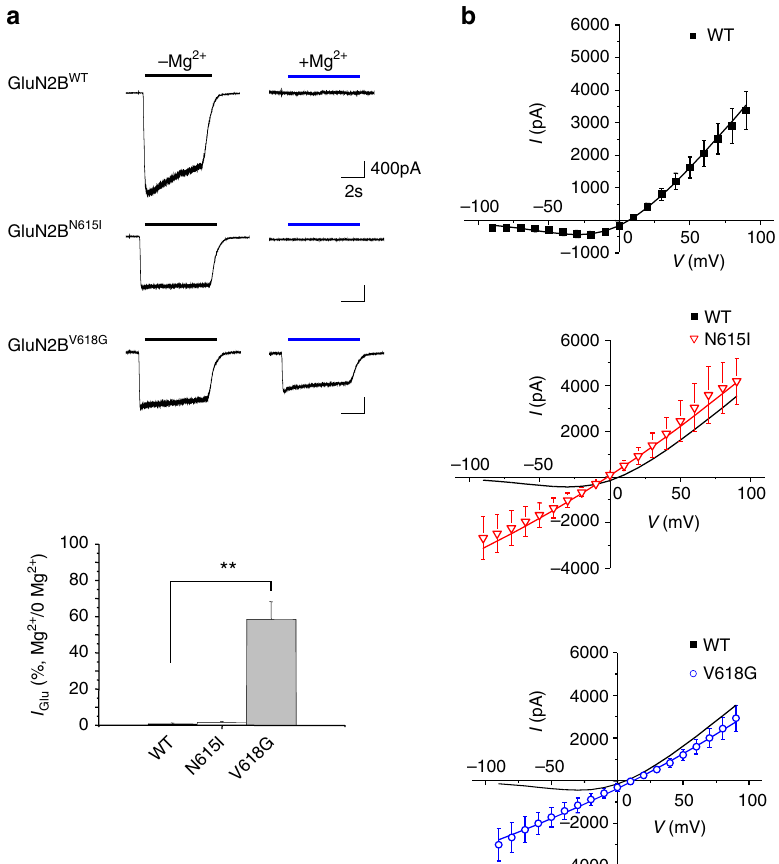
Fig. 4 Mg 2+ permeability and block of NMDARs. a Ion permeability experiments using Mg 2+ solution applied to HEK293 cells at − 60 mV. Upper panel, NMDARs are exposed to 10 μ M glutamate and 10 μ M glycine either in nominally 0 Mg 2+ Krebs ( − Mg 2+ ) or in Mg 2+ solution (+Mg 2+ ). Lower panel, bargraph of glutamate currents ( I Glu ) presented as a percentage I Glu in Mg 2+ solution/ I Glu in 0 Mg 2+ Krebs. Membrane current in Mg 2+ solution was only evident with GluN1 – GluN2B V618G . One-way ANOVA with Dunnett ’ s post-hoc test, ** p < 0.01. b I – V relationships in Krebs solution (with 1.2 mM Mg 2+ ) generated by a voltage step protocol (from − 90 to +90 mV) in the presence of 10 μ M glutamate and 10 μ M glycine. The curve fi ts used in all plots were generated using the trapping model (black: WT; red: N615I; blue: